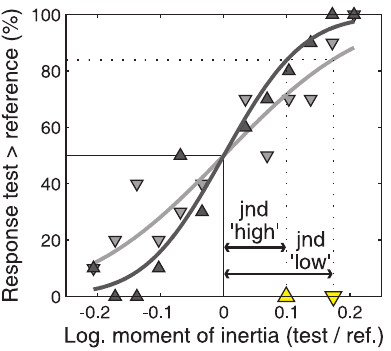
Figure 3. Psychometric function. An exemplary participant’s responses in the low and high force conditions and the psychometric curves (cumulative Gaussians) fitted to the responses. On the x -axis are the log-transformed values for moment of inertial for the twelve test stimuli relative to the reference stimulus. On the y -axis are the participant’s responses, that is, the percentage of trials in which each test stimulus was judged to have a larger moment of inertia than the reference stimulus. The light gray downward pointing triangles and dark gray upward pointing triangles correspond to the responses in the low and high force condition, respectively. The curves’ standard deviations (jnd) are indicated with the yellow triangles on the x -axis. The Weber fraction is defined as the jnd divided by the reference stimulus’ moment of inertia. See section ‘‘analysis’’ for further details.